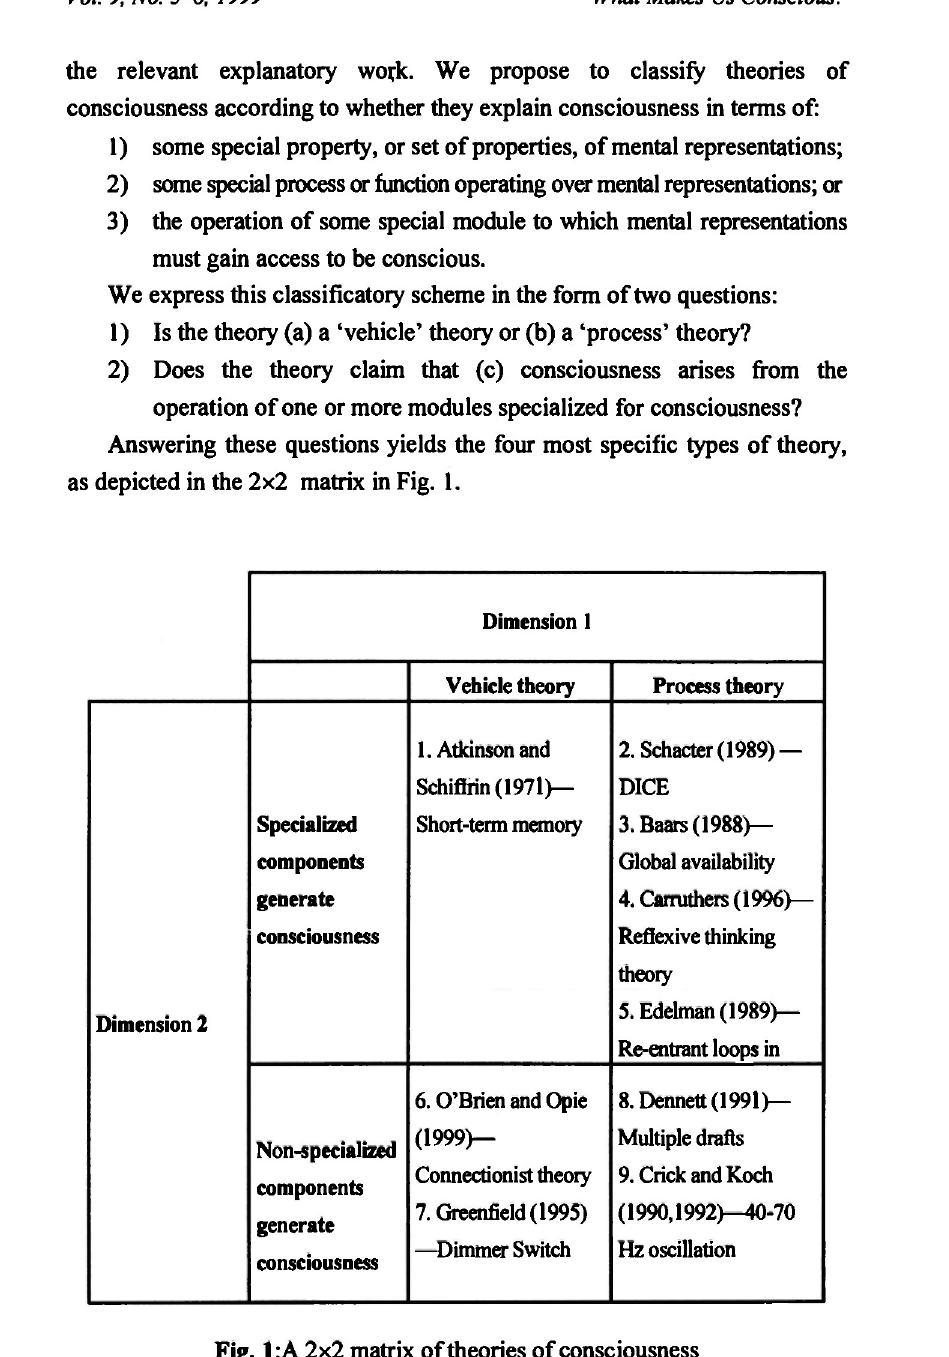
Fig. 1:A 2x2 matrix of theories of consciousness